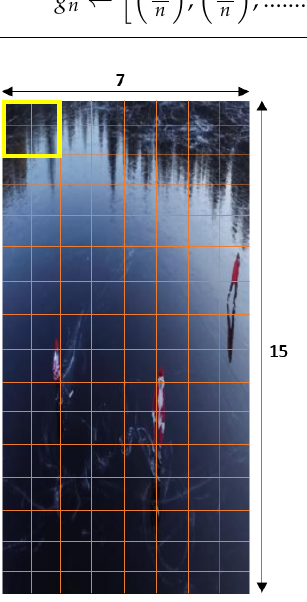
Figure 9. HOG features